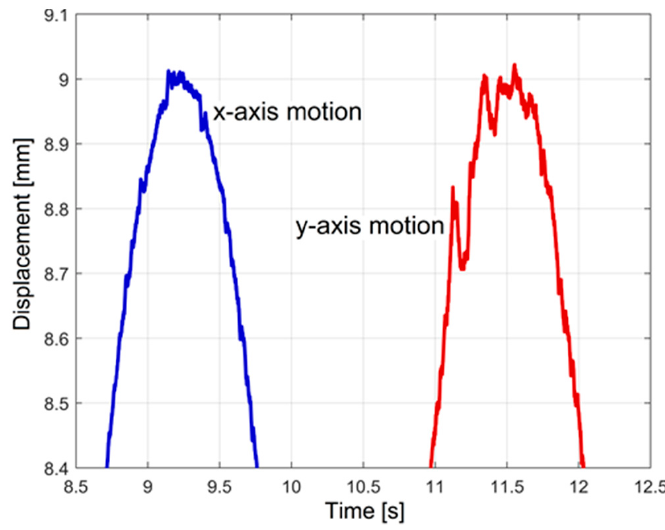
Figure 5. A zoomed in portion of Figure 4 (in area